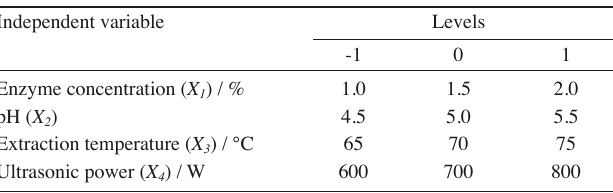
Tab. 1: Independent variable values of the process and their corresponding